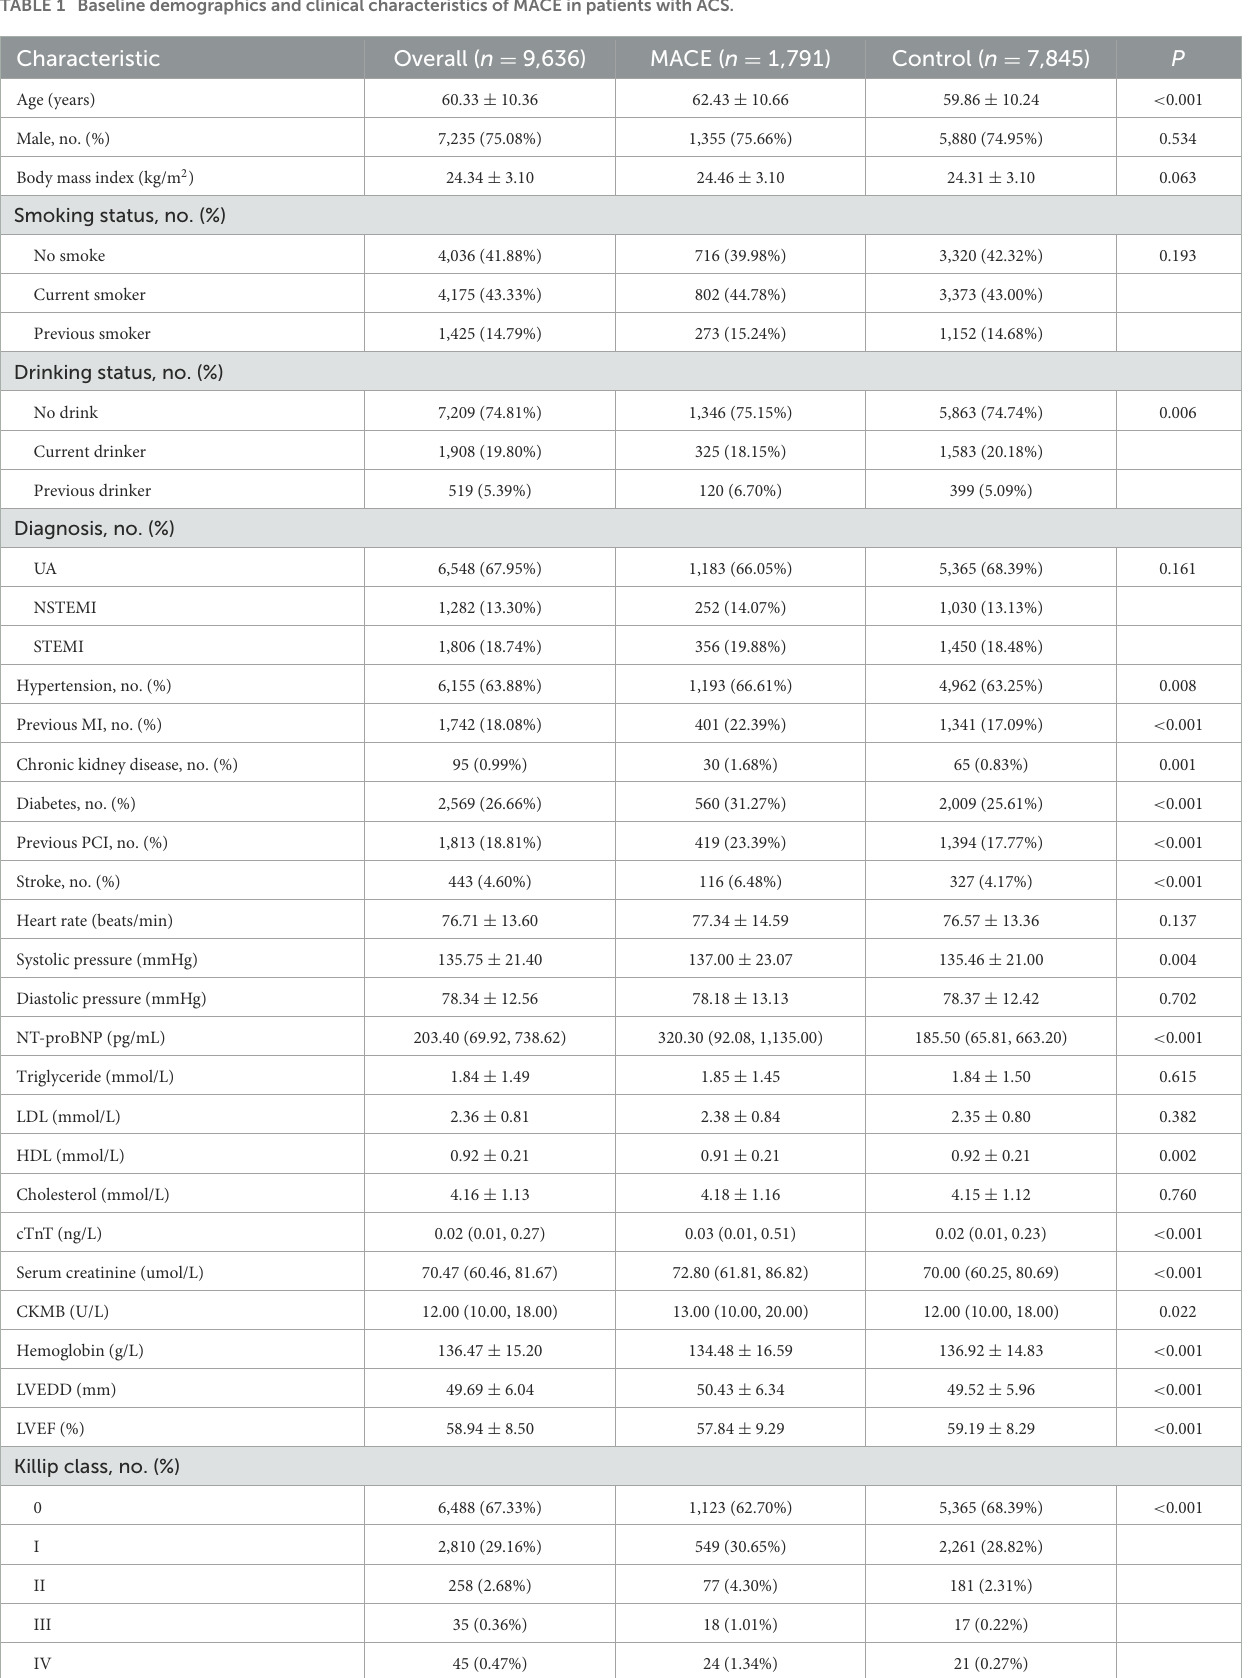
TABLE 1 Baseline demographics and clinical characteristics of MACE in patients with ACS.